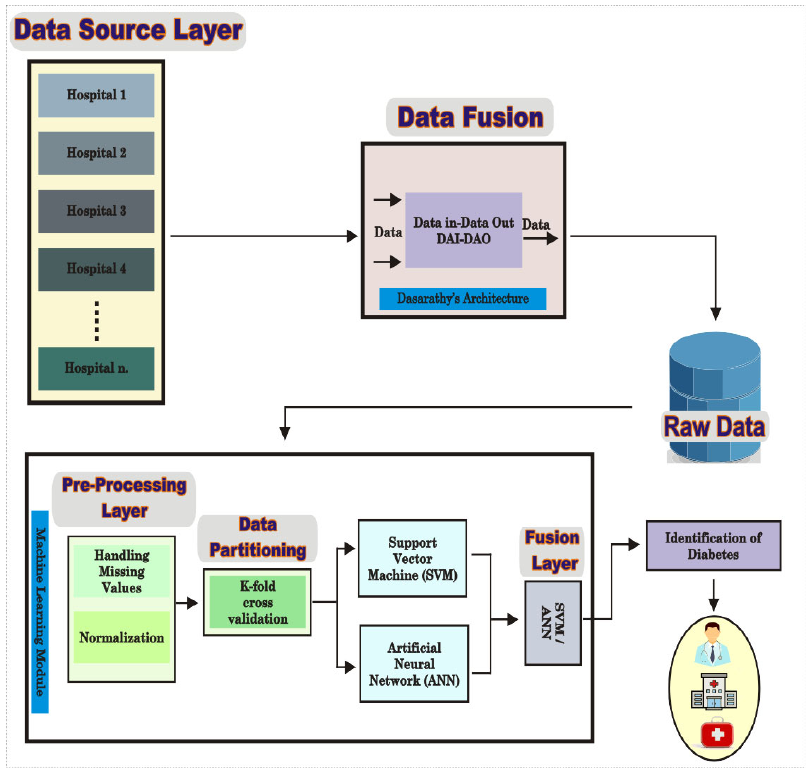
Figure 1. The System Architecture of the Proposed Fusion ‐ based Prediction Approach.